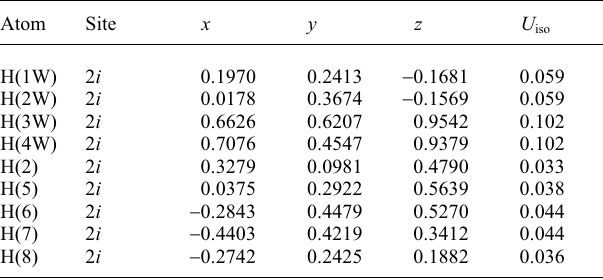
Table 2. Atomic coordinates and displacement parameters (in Å 2 )